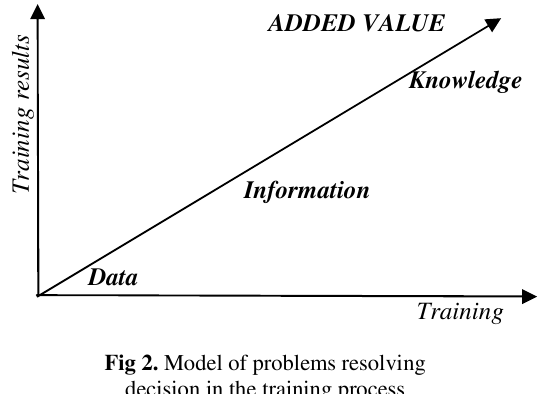
Fig 2. Model of problems resolving decision in the training